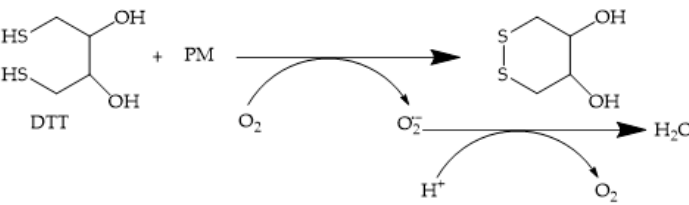
Figure 3. Reactions between dithiothreitol (DTT) and O 2 with particulate matters (PMs) as a catalyst [27].